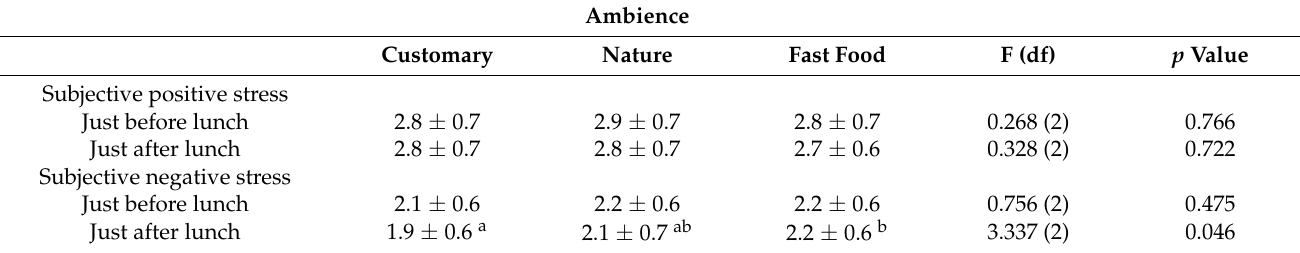
Table 2. Subjective positive and negative stress just before and just after lunch during the study weeks measured on a scale in which 1 = low intensity and 5 = high intensity. Data from the subgroup of participants ( n = 32). Different letters next to the means indicate statistically significant difference ( p ≤ 0.1) between the study weeks.